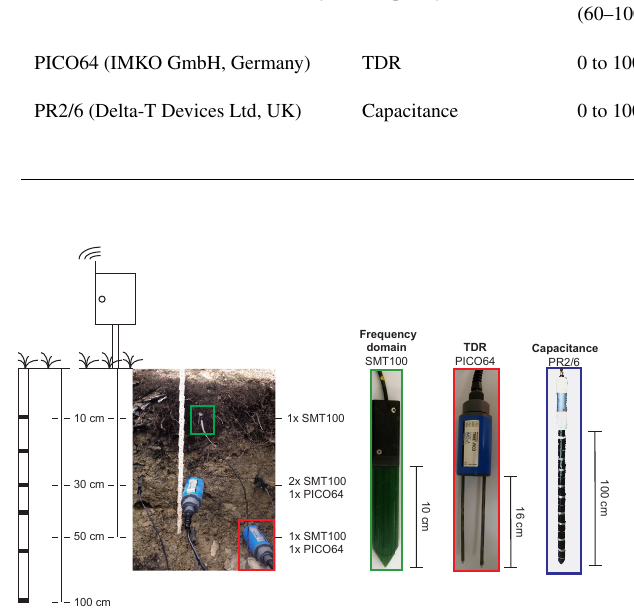
Figure 2. Instrumentation of the standard SOMOMOUNT